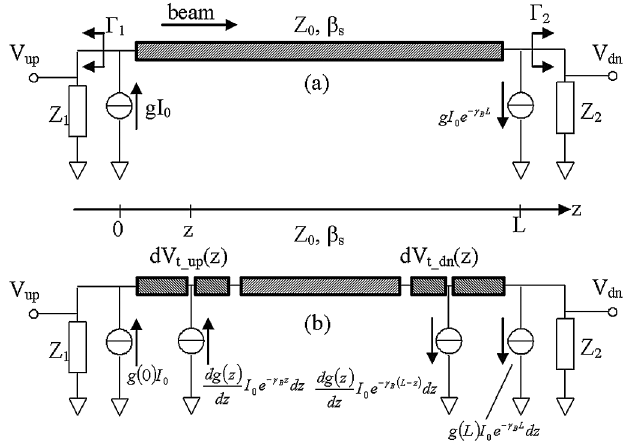
FIG. 16. Equivalent circuits of a stripline excited by the beam: (a) uniform stripline; (b) tapered